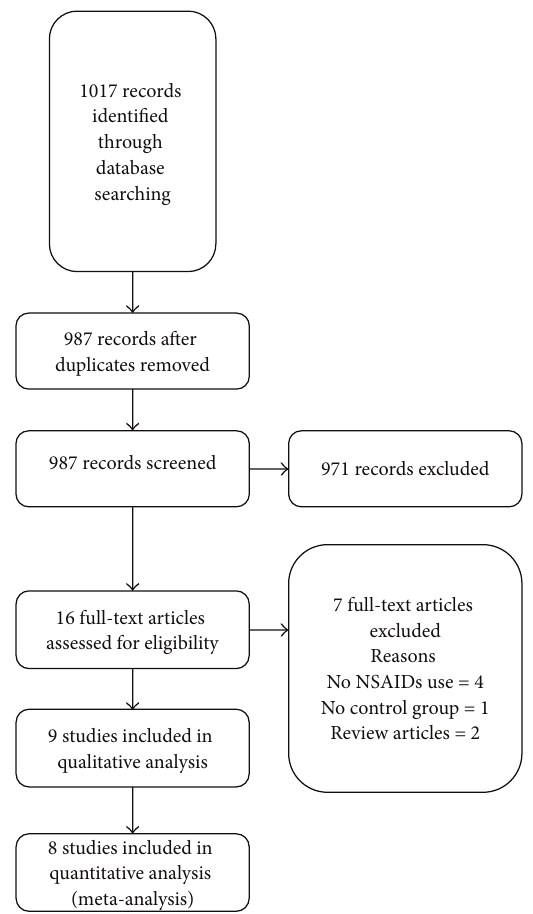
Figure 1: Results of information search.